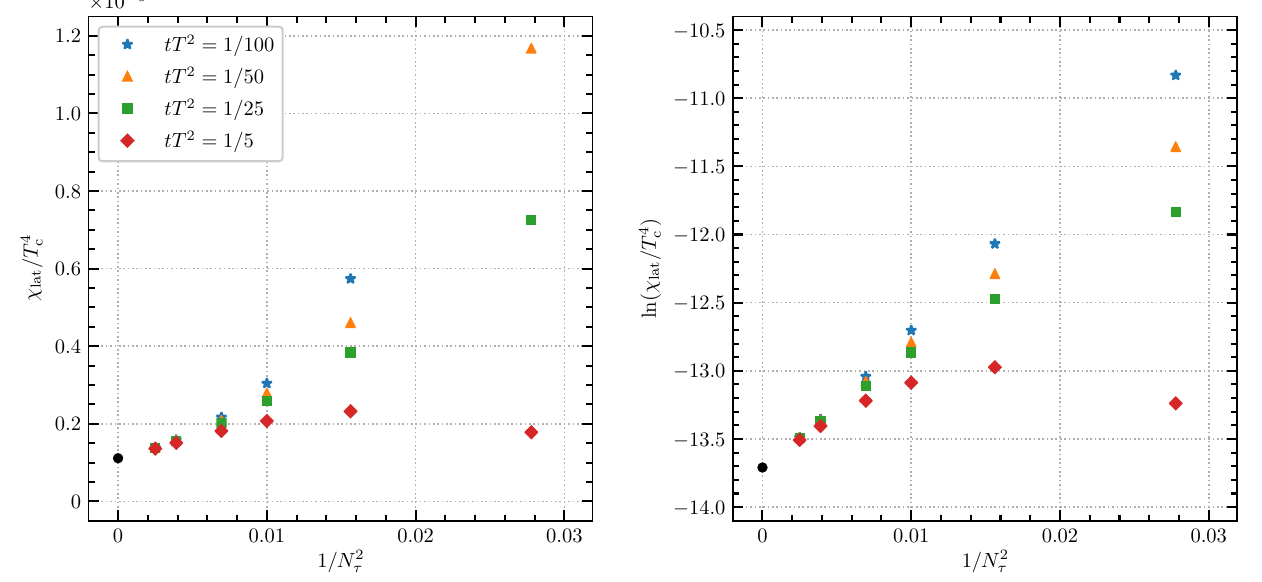
Fig. 7 Left: Continuum extrapolation Eq. (25) at T / T c = 4 at fixed (Wilson) flow time. Right: Logarithm of left plot. The black point represents the continuum